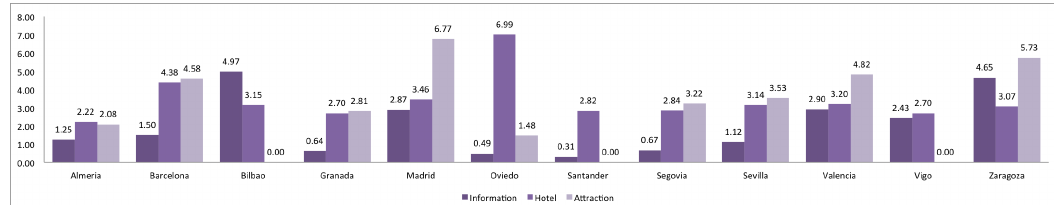
Figure 10. Consistency study of shop in Spain. Standard deviation of tag number.